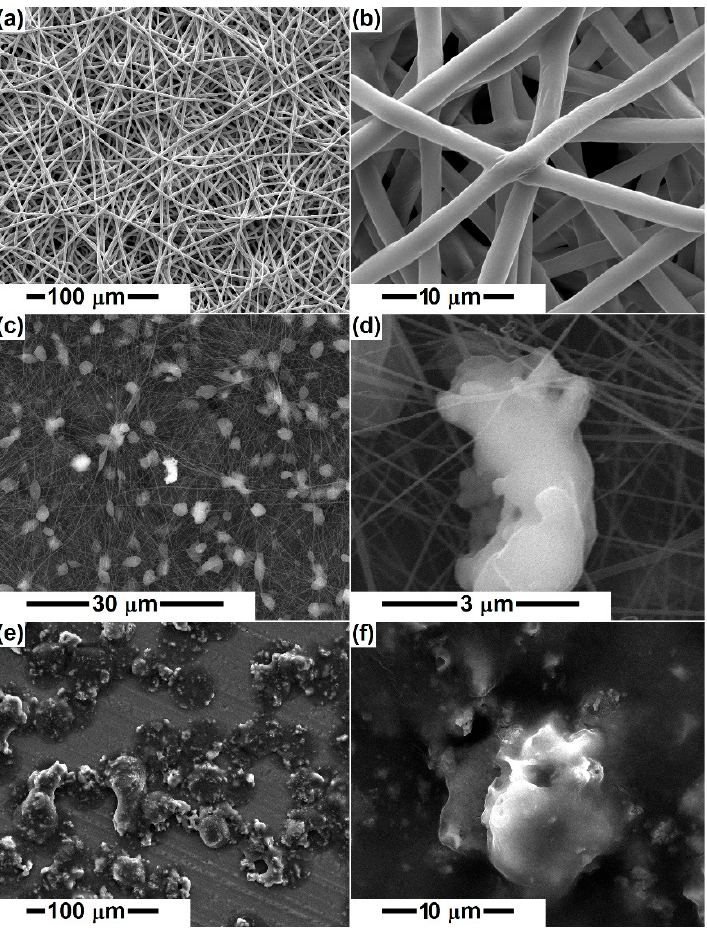
Figure 1. SEM images of the electrospun samples: ( a , b ) PCL, ( c , d ) PCL-D-5%, and ( e , f ) PCL-D-10%.